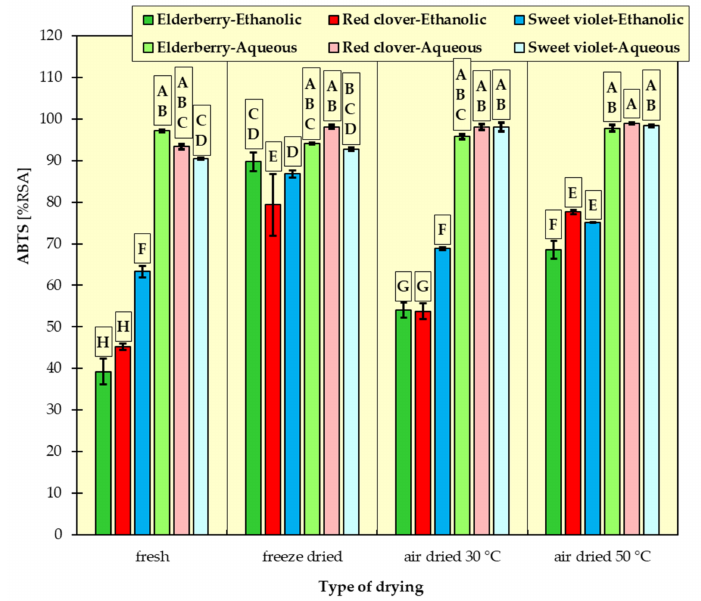
Figure 4. Radical-scavenging activity of ethanolic and aqueous extracts from red clover, sweet violet and elderberry flowers assessed in ABTS method. All data are expressed as mean ± SD. Bars with a different letter indicate significant differences according to HDS Tukey’s test ( p < 0.05 was accepted as statistically significant). Homogeneous groups are marked with the same letters.